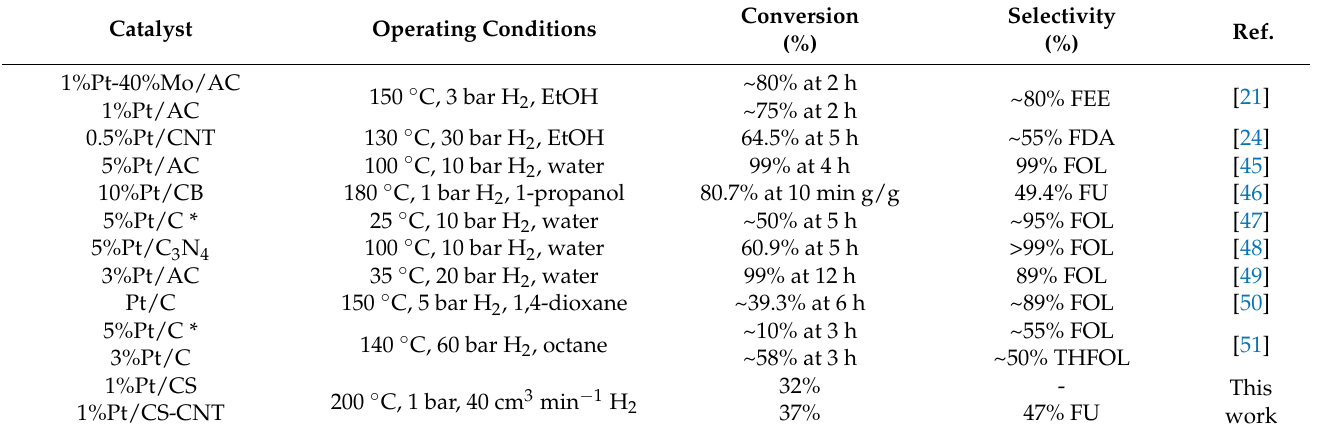
Table 3. Hydrogenation of FUR over different Pt-catalysts supported on carbon materials.